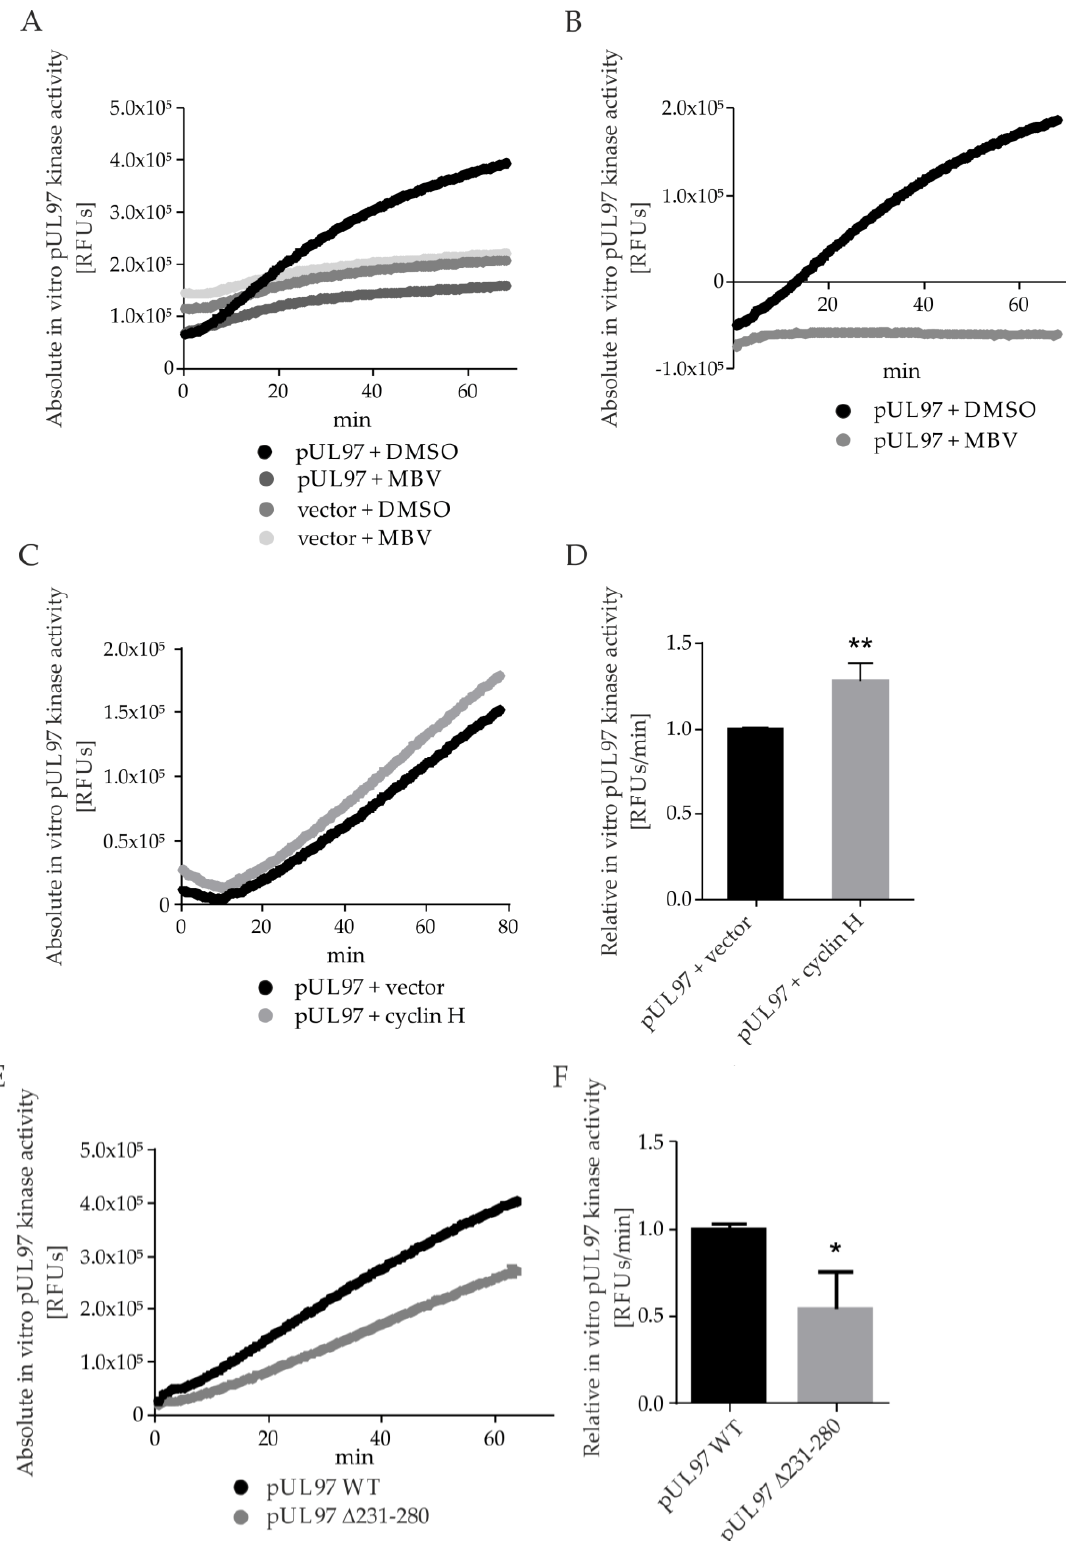
Figure 9. Application of the qSox-IVKA for quantitative measurement of in vitro pUL97 kinase activity. The 293T cells were seeded in 10-cm 2 dishes for transfection on the following day using plasmids coding for pUL97-Flag or empty vector control. At 1 day post-transfection (d.p.t.), cells were lysed and pUL97-Flag was immunoprecipitated using 25 µL Dynabeads ® protein A coupled with Flag-tag specific antibodies. Dynabead-bound proteins were then eluted in 50 µL enzyme buffer and used for qSox-IVKA. For these reactions, 40 µL of kinase reaction mix was pipetted in Corning NBS 96-well half area microplates, before 10 µL Dynabeads protein solution was added. Kinase activity was measured using a Victor multilabel reader, at every 30 sec of the kinetics for approxi- mately 80 min. Values of pUL97 activity were normalized according to the expression levels on Wbs. ( A ) Absolute values of the measured RFUs for pUL97 and vector control, as treated with 5 µM of MBV or DMSO as the solvent control; measurements were performed in duplicate. ( B ) Empty vector controls from panel A were used for normalization of pUL97 signal intensities, to depict the specific activity. ( C ) The pUL97 kinase activity was determined by qSox-IVKA under conditions with or without cyclin H-HA coexpression (transient cotransfection setting); mean values of duplicates are given. ( D ) Relative pUL97 + cyclin H activity per min was calculated for the linear proportion of the curve obtained in panel C for 20 – 70 min, normalized to pUL97 + vector control. Statistical analysis was performed using an ordinary two-way ANOVA and post-hoc Sidak correction; **, p < 0.01. ( E ) Mutant kinase activity of construct pUL97 Δ 231-280 was compared with pUL97 WT (both Flag- tagged), by qSox-IVKA. Mean values are given of two independent experiments, with measure- ments taken in duplicate. ( F ) Relative pUL97 activity per minute was calculated for the linear pro- portion of the curve obtained in panel E for 20 – 60 min, normalized to pUL97-Flag. Statistical analy- sis was performed using an ordinary two-way ANOVA and post-hoc Sidak correction; *, p < 0.05. 3. Discussion Within the present study, we describe a many-layered panel of experimentation that addresses our focus on the functional importance of viral pUL97 – cyclin interaction. A summarized view of the findings, obtained through the analysis of clinically relevant HCMV mutants and various methodological settings of recombinant expression, strongly supports our earlier data pointing to the functional significance of cyclin binding [10,20,22]. In vitro pUL97 kinase activity and the efficiency of viral replication demon- strate a clear enhancement mediated through pUL97 – cyclin interaction, as measured by the independent testing systems, at least as far as cyclin H is concerned (Table 2). Clini- cally relevant virus mutants, carrying amino acid replacements in pUL97, with or without conferring drug resistance, behaved mostly like the WT in terms of viral replication kinet- ics, cyclin binding, and kinase activity (see Figures 1 – 4, 7, and 9). Importantly, however, deletion mutants in the cyclin IF2 region of pUL97, i.e., Δ 231-280 or similar, resulted in defective or changed features of activity. Likewise, KO or modulated expression of cyclin H exerted a strong HCMV-specific, regulatory impact (see Figures 5, 6, 8, and 9). These points add to our refined understanding of the highly conserved pUL97 – cyclin interaction